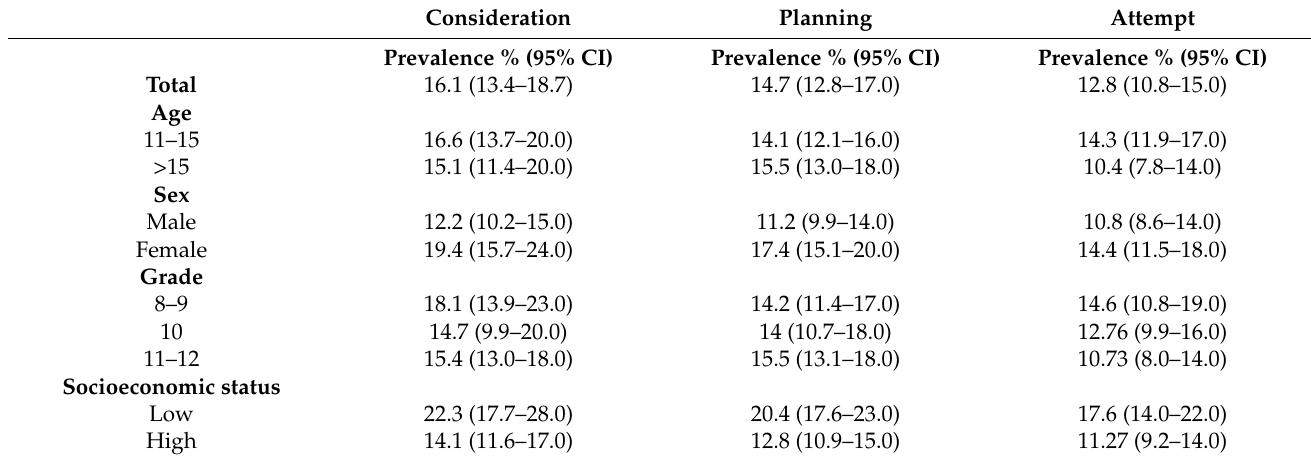
Table 2. Prevalence of suicidality among adolescents aged 11–18 in Mauritius,